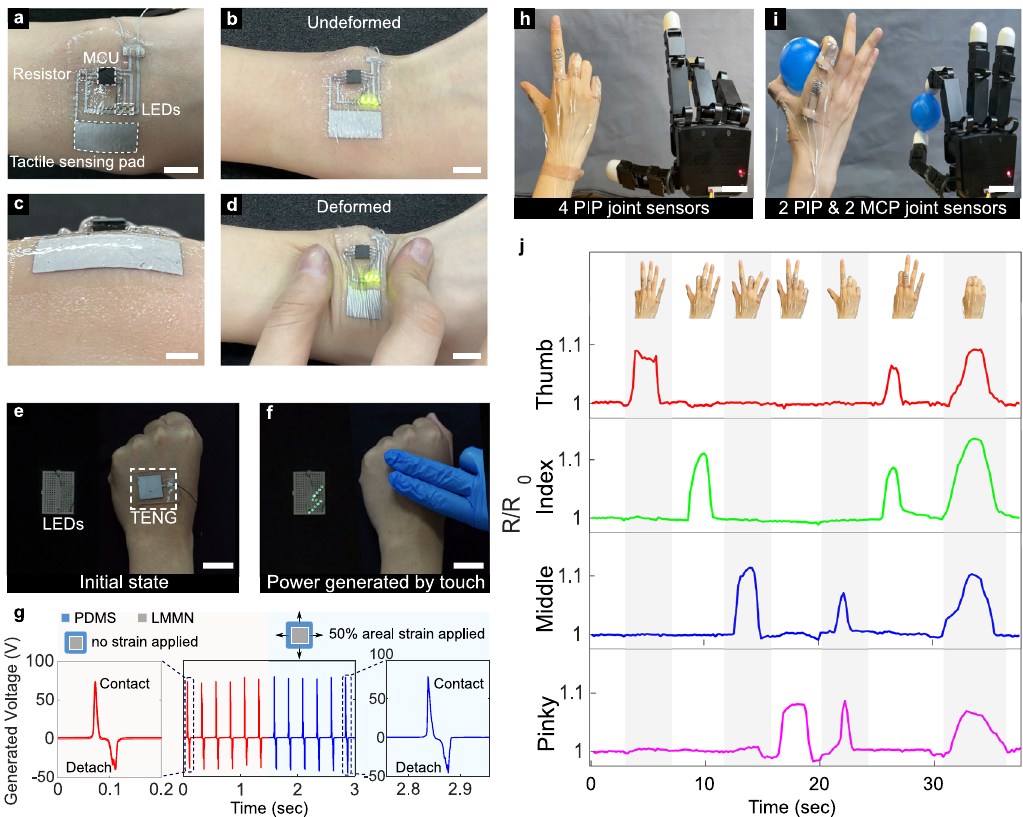
Fig. 5 Applications of LMMN fi lms. a – d A skin-attachable circuit board patterned with LMMN fi lms attached to a human wrist ( a , b ; scale bars: 1 cm). The device robustly operates without deformation ( c ; scale bar: 5 mm) and with deformation ( d ; scale bar: 1 cm). e – g LMMN fi lm utilized as a triboelectric nanogenerator (TENG). e LMMN-TENG mounted on a human hand (scale bar: 2 cm). f Electrical current lighting up eleven LEDs is generated under gentle touch (scale bar: 2 cm). g Voltage output under zero strain (red) and when 50% of areal strain is applied to the substrate (blue). Peak-to-peak voltages up to 120 V were generated with consistency. h – j Finger fl exion sensors for the teleoperation of a robotic hand. h Photograph of the demonstration with four PIP joint sensors (scale bar: 3 cm). i Photograph of the demonstration with two PIP joints and two metacarpophalangeal joints (MCP) joints (scale bar: 3 cm). j Relative resistance changes of four PIP joint sensors with different hand